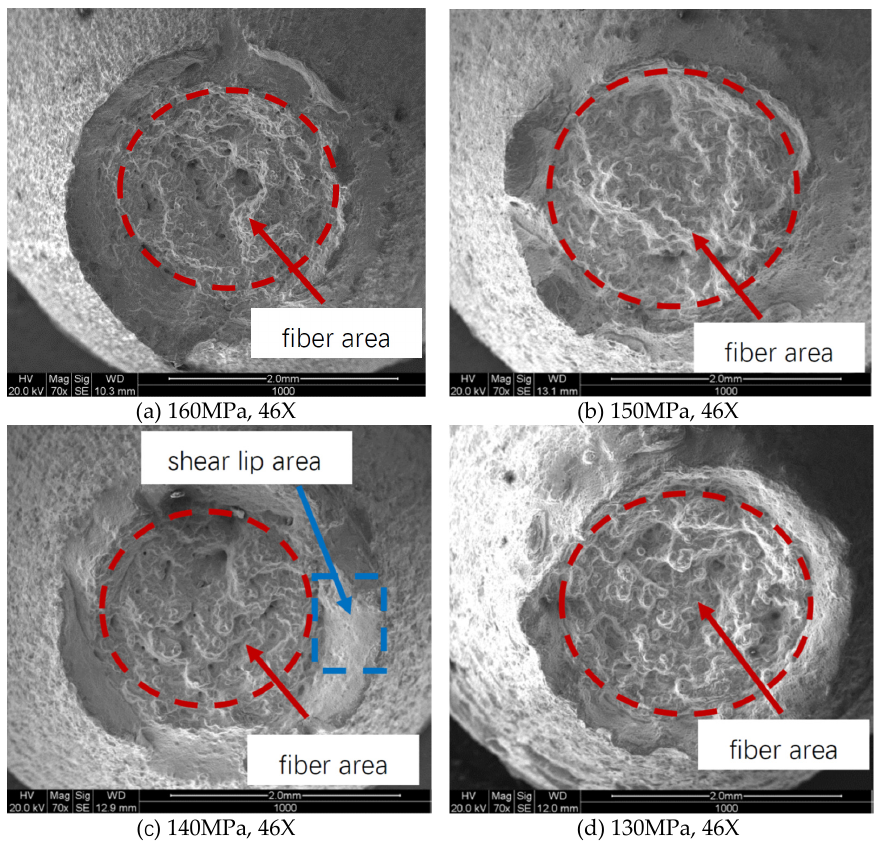
Figure 9. Fracture morphology of the 580 °C creep specimen.